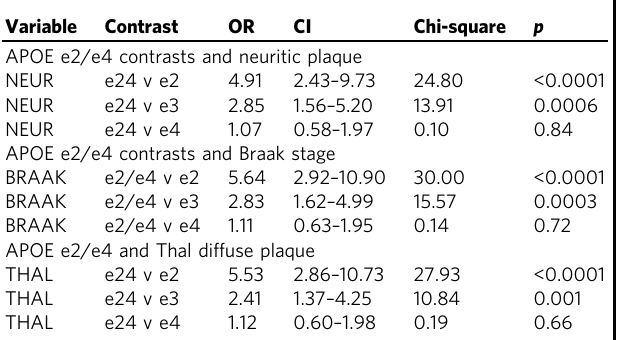
Table 2 APOE e2/e4 logistic regressions for AD